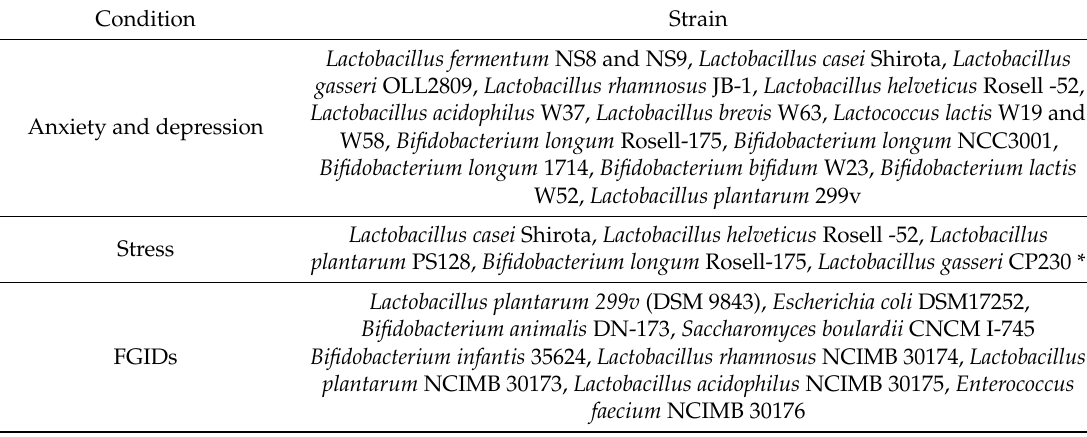
Table 2. Probiotics strains with documented efficacy in gut-brain axis disorders [144,148,166,172].